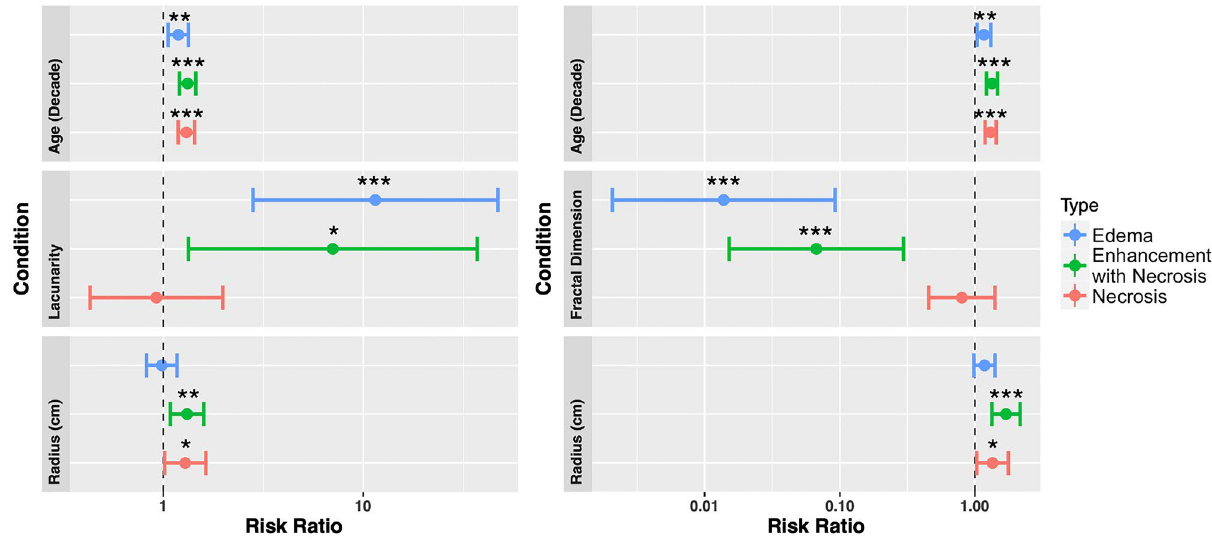
Figure 5. (Left) Multivariate CPH models of lacunarity, age at diagnosis, and abnormality radius for necrosis (n = 390), enhancement with necrosis (n = 402), and edema regions (n = 257). Lacunarity of both edema and enhancement with necrosis were significant predictors of overall survival in their respective models (p = 0.0007 and p = 0.042, respectively). Age at diagnosis, as expected, was consistently significant for survival. Radius was a significant predictor for regions of necrosis and enhancement with necrosis (p = 0.036). (Right) Corresponding Cox proportional hazard model of fractal dimension, age at diagnosis, and abnormality radii for necrosis, enhancement with necrosis, and edematous regions. Fractal dimension values of both edema and enhancement with necrosis were significant predictors of overall survival in their respective CPH models (p < 0.0001 and p = 0.0003, respectively). Age at diagnosis was consistently significant across all CPH models, while only enhancement with necrosis, and necrosis radii were significant (p = 0.0018 and p = 0.028, respectively). For a complete table including confidence intervals and significance values, see Supplement